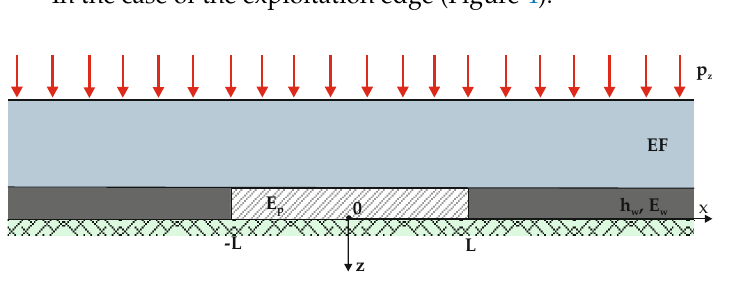
Figure 4. A model of goafs and undisturbed coal body.